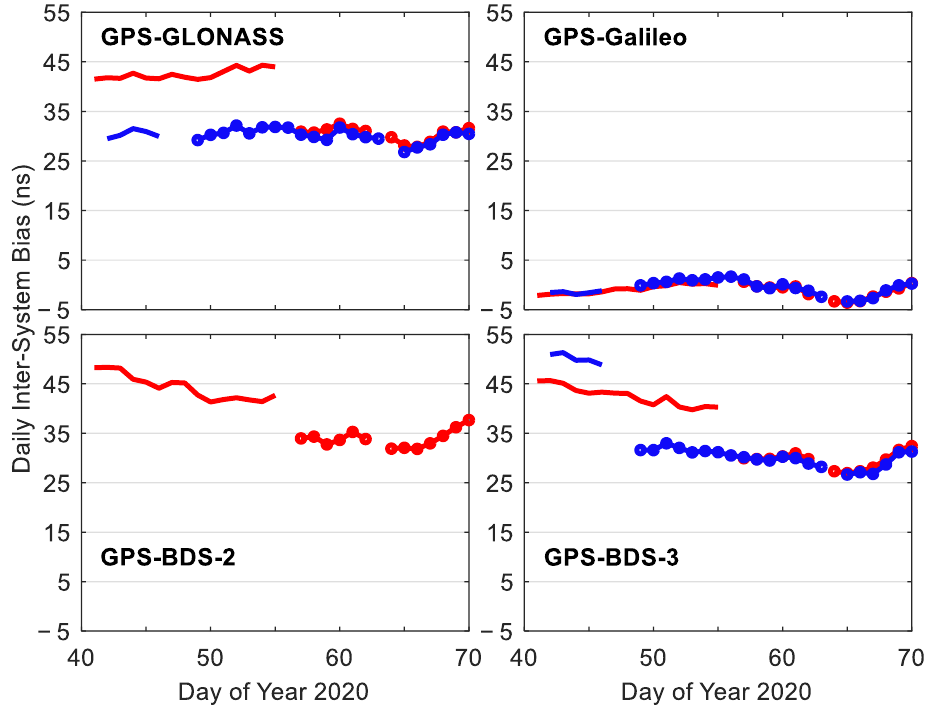
Figure 4. Time series of daily ISBs at BRUX (red) and UNSA (blue) stations (characterized by the replacement of receiver types).